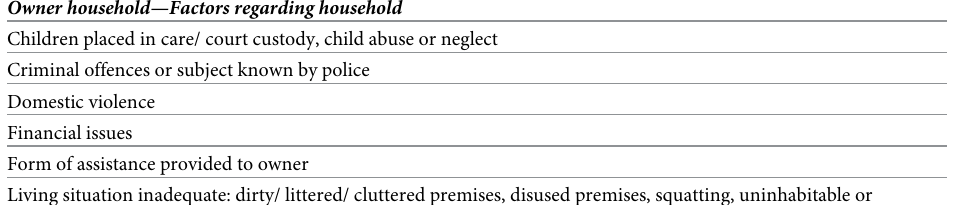
Table 1. Dog owner and dog ownership factors studied. Dog owner and dog ownership factors studied, categorised into four categories: ‘owner household’, ‘owner antisocial behaviours’, ‘husbandry/ animal view’ and ‘animal